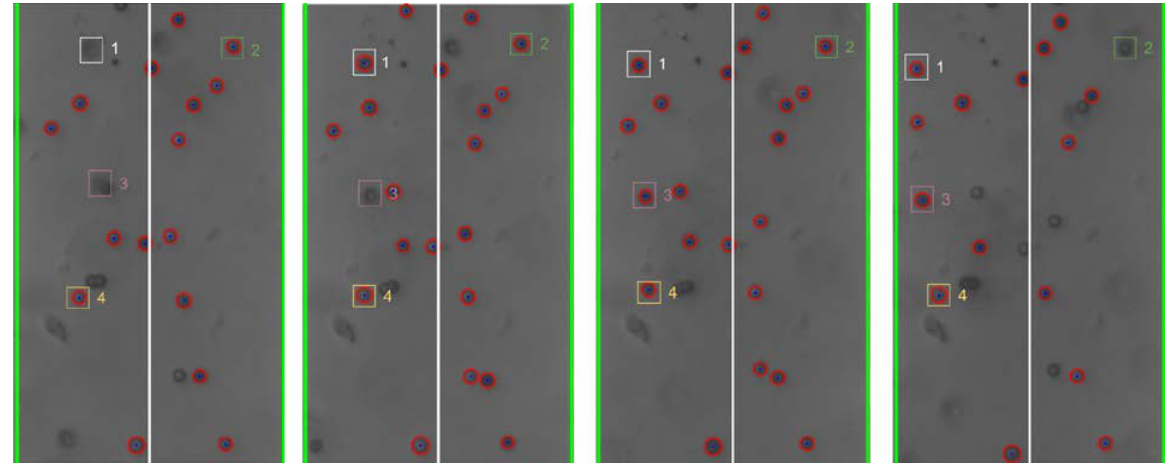
Figure 8. Individual bead movement during Trial 2 from frames 195 to 298.